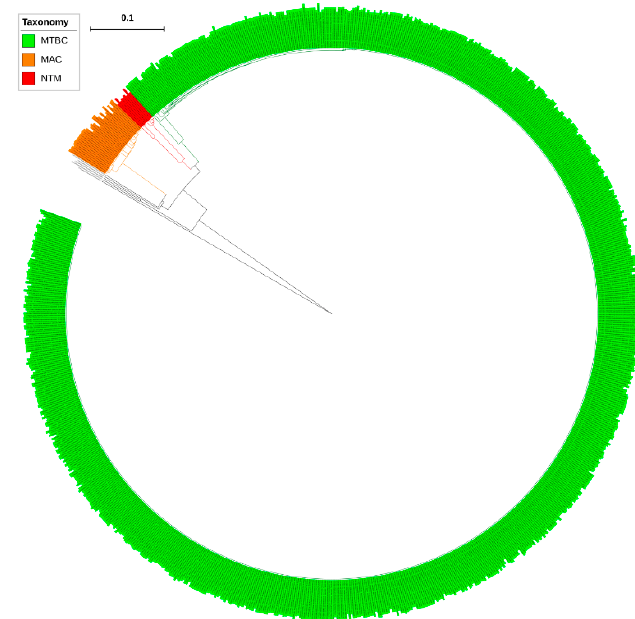
Figure 2. Phylogenetic analysis of CYP139A P450s. Different mycobacterial categories were indicated in different colours. CYP51B1 from Mycobacterium tuberculosis H37Rv is used as an outgroup. Abbreviations: MTBC, Mycobacterium tuberculosis complex; MAV, M. avium complex; NTM, non-tuberculosis mycobacteria. A high-resolution phylogenetic tree is provided in Supplementary Figure S1. Table 1. Comparative amino acid conservation analysis of CYP139 P450 family with top 10 ranked P450 families [23,25]. The conservation index score is obtained as described in the section on materials and methods, following the procedure described elsewhere [27]. The conservation score (5–9) obtained via PROMALS3D is presented in the table, where the number 9 indicates invariantly conserved amino acids in P450 members. P450 families were arranged from the highest to the lowest number of amino acids conserved. CYP139 P450 family is indicated in